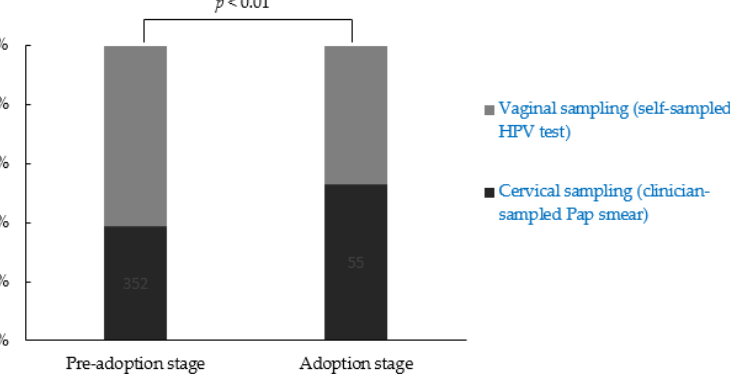
Figure 1. Preference in terms of screening methods according to the decisional stage of cervical screening adoption. The pre-adoption stage group, which included stages 1 (unawareness), 2